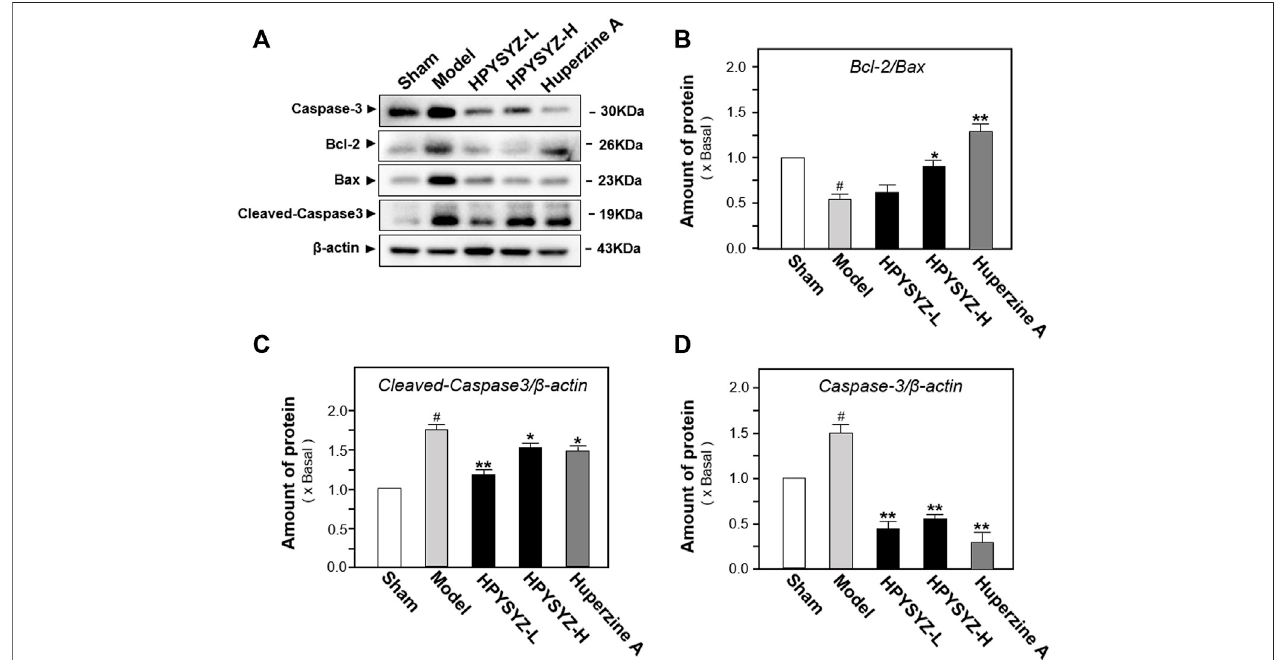
FIGURE 3 | Ethyl acetate extracts of succinum regulated the caspase-dependent pathway in the hippocampus of carotid artery ligation rats. (A) Effects of ethyl acetate extracts of succinum at low dosage (HPYSYZ-L) and high dosage (HPYSYZ-H) on the expressions of caspase-3, cleaved-caspase-3, and Bax and Bcl-2 of hippocampus of carotid artery ligation rats were evaluated by Western blotting analysis. The representative images are displayed ( n = 5). (B) Expression of caspase-3 wasanalyzedandtheexpressionof β -actinwasappliedfornormalization.Expressionofcleave-caspase-3wasanalyzedandtheexpressionof β -actinwasapplied fornormalization. (D) ExpressionsofBaxandBcl-2wereanalyzedandtheexpressionof β -actinwasalsousedfornormalization.TheexpressionratioofBcl-2toBaxwas calculated. Values are expressed as the percentage of the control group (no drug treatment normal mice) as mean ± SEM (n = 5). Comparisons between groups were analyzed by a one-way ANOVA followed by a post hoc Bonferroni test. ## p < 0.01 (compared with control group), * p < 0.05, and ** p < 0.05 (compared with the model